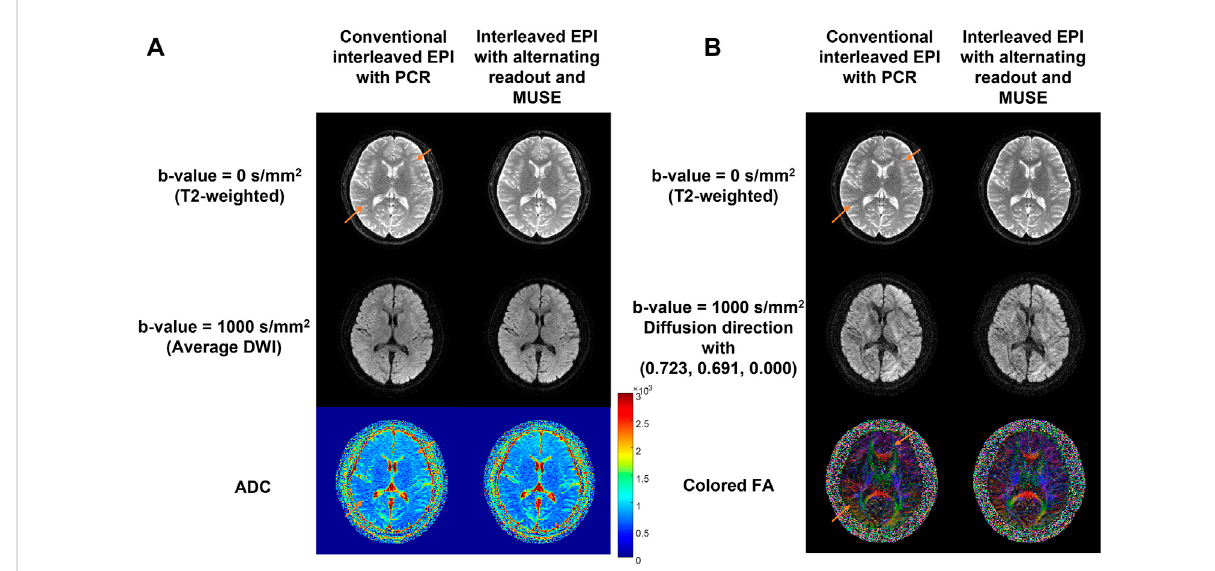
FIGURE 8 Comparisonbetweentheconventional4-shotinterleavedEPIwithPCRandtheproposedmethodindiffusionimaging.Leftpanel (A) showsthe DWI results and right panel (B) shows the DTI results. The reconstructed T2-weighted images (top row), average DW images (A) /DW images with a representative diffusion direction (B) at b-value = 1000 s/mm 2 (middle row) and ADC (A) /FA (B) maps (bottom row) from two reconstruction methods are shown. The residual aliasing artifacts are marked using orange arrows. This in-vivo test demonstrated that the proposed method can completely eliminate the residual Nyquist ghost artifact, and therefore enable high-quality mapping of MRI biomarkers using multi-shot interleaved EPI.